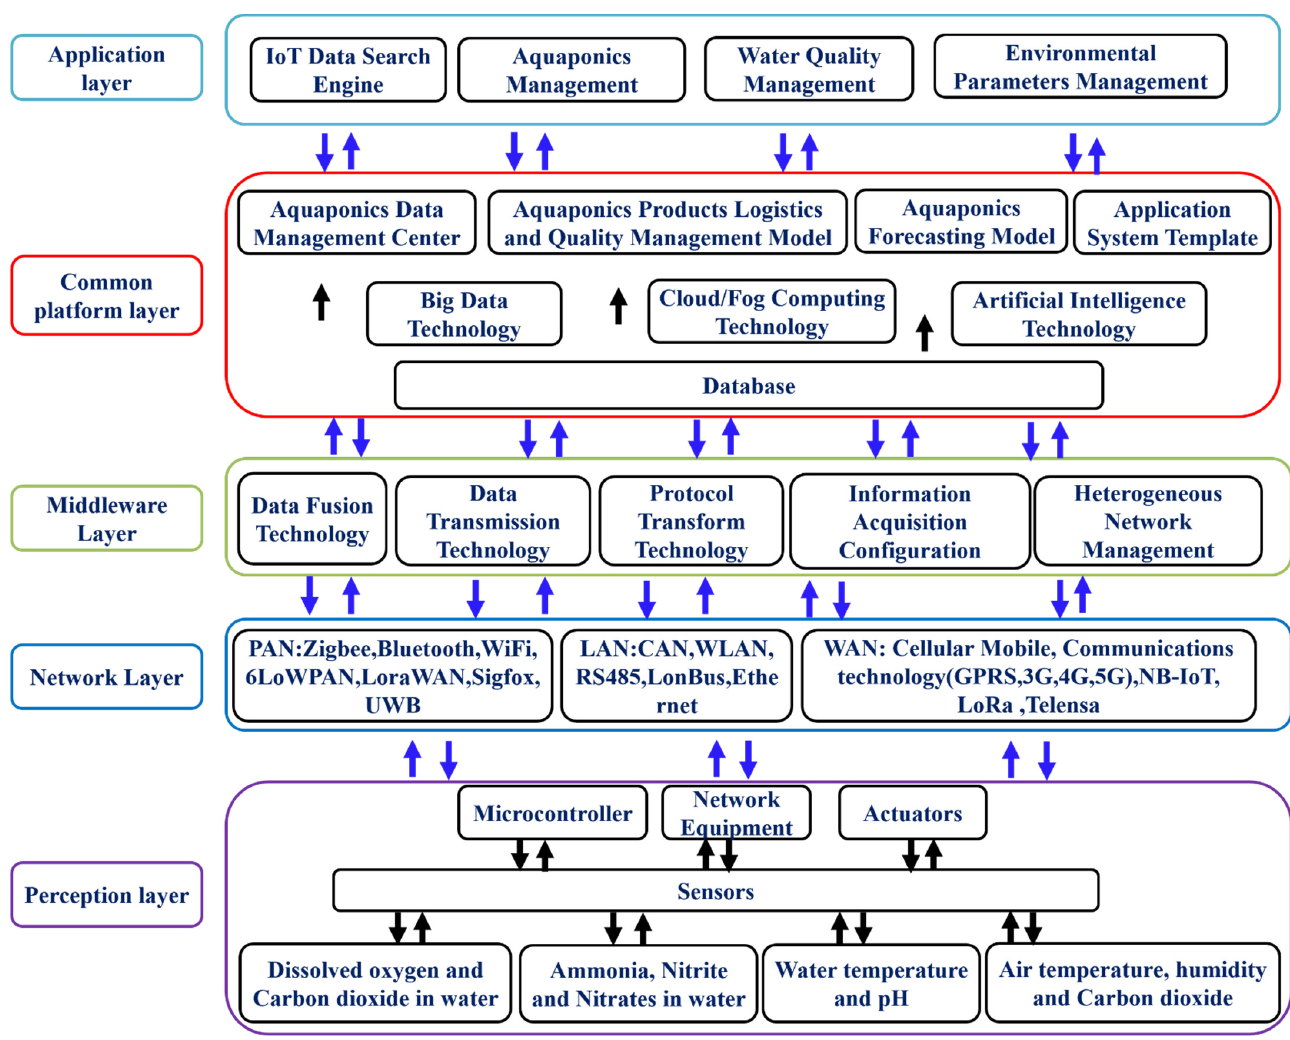
Figure 7. Structure of IoT in aquaponics.